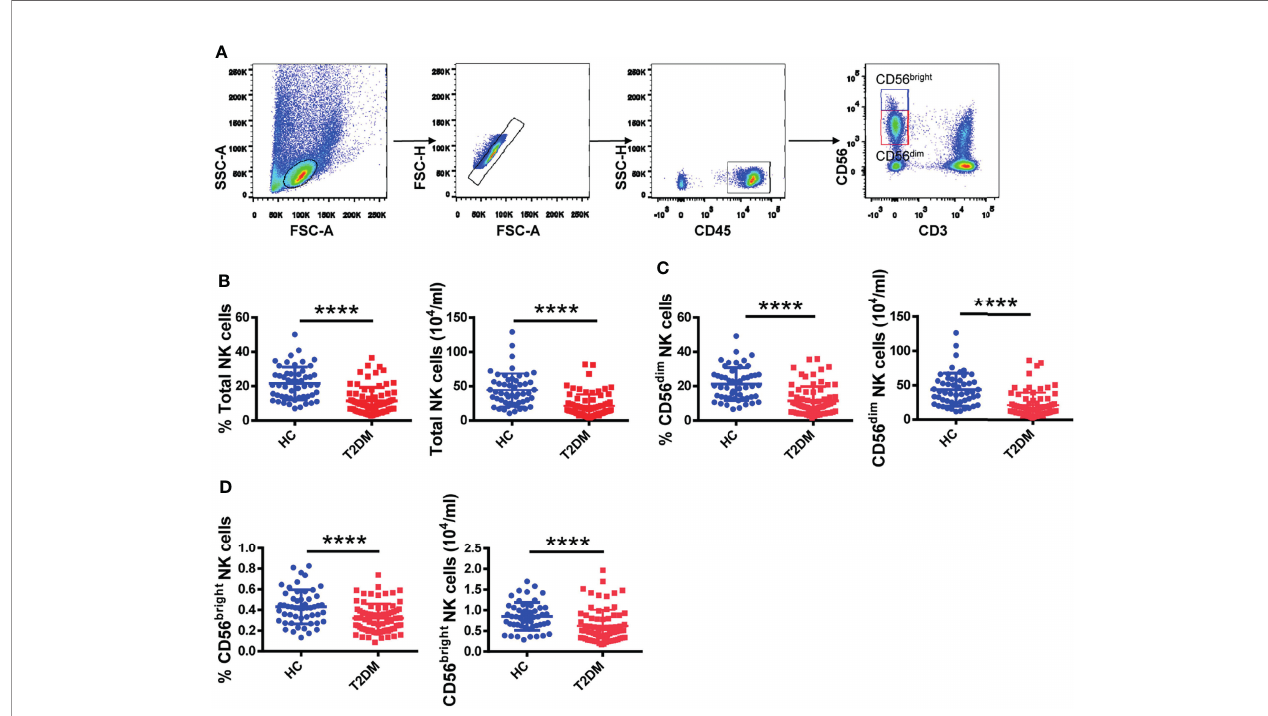
FIGURE 1 | Circulating NK cell counts are decreased in T2DM patients. (A) Sequential strategy for gating CD56 dim and CD56 bright NK cells from PBMCs using fl ow cytometry. Flow cytometry estimations of frequency and absolute number of total NK cells (B) , CD56 dim NK cells (C) , and CD56 bright NK cells (D) in patients with T2DM and healthy controls (HC). Each dot represents a different individual and results are presented as the mean ± SEM; ****p <